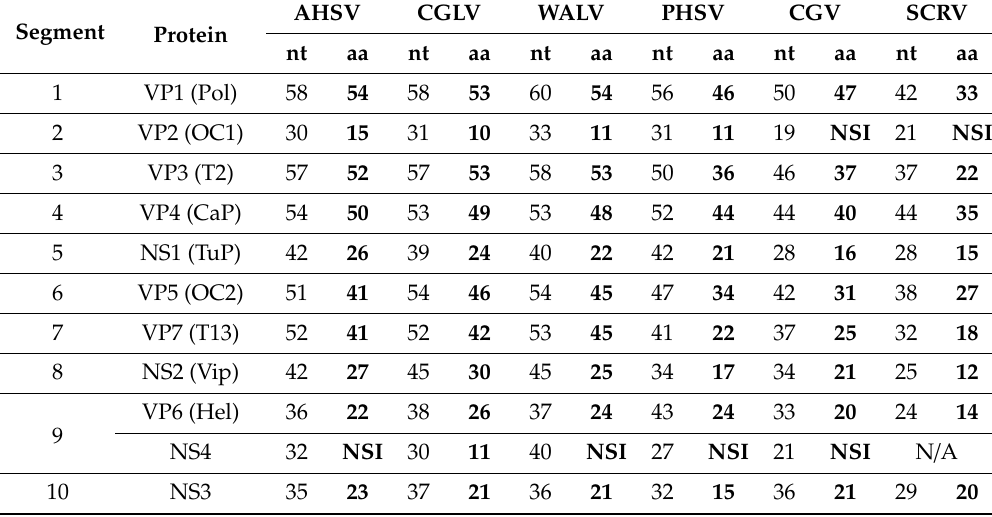
Table 2. Nucleotide (nt) and amino acid (aa) identities between LEAV and some representative orbiviruses: Culicoides -borne (AHSV, African Horse Sickness virus; WALV, Wallal virus), sandfly-borne (CGLV), mosquito-borne (PHSV, Peruvian horse sickness virus), tick-borne (CGV, Changuinola virus) and tick orbivirus (SCRV, St. Croix River virus). Segment